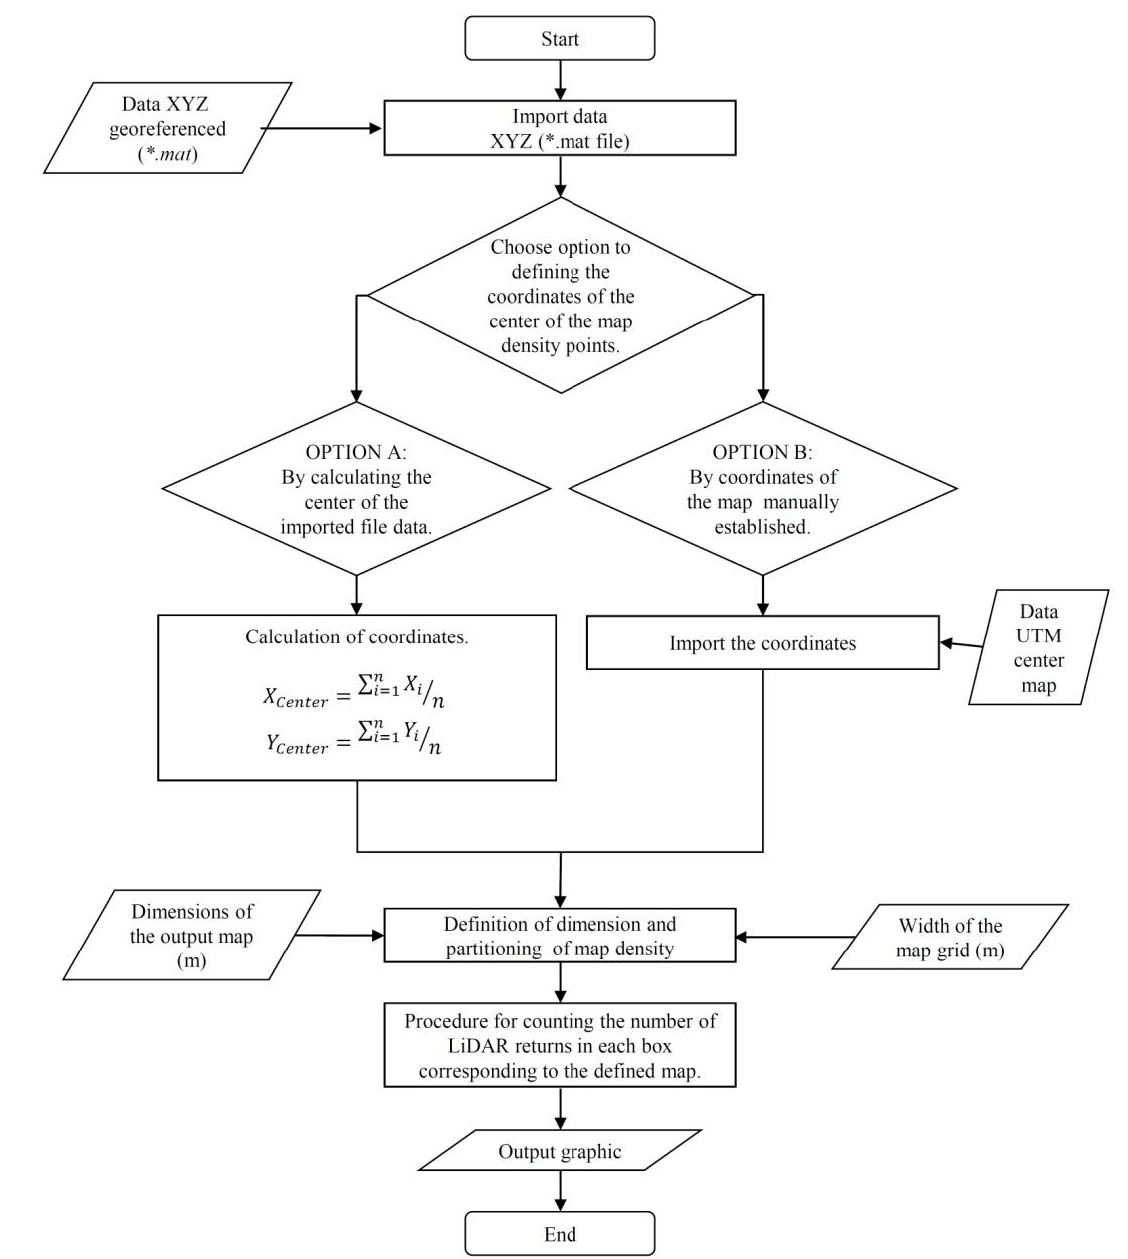
Figure 9. Flow chart of the second part of the georeferencing